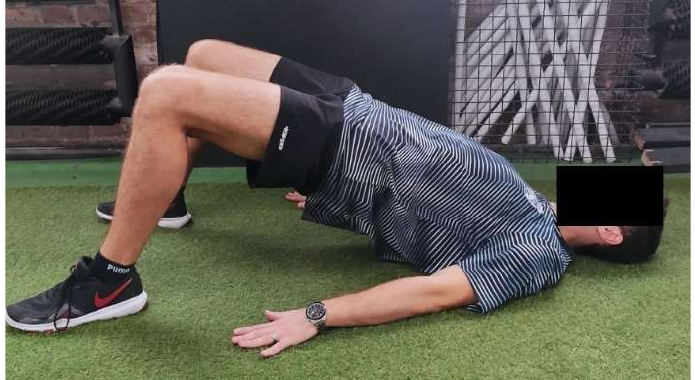
Figure A1. Glute Bridge.